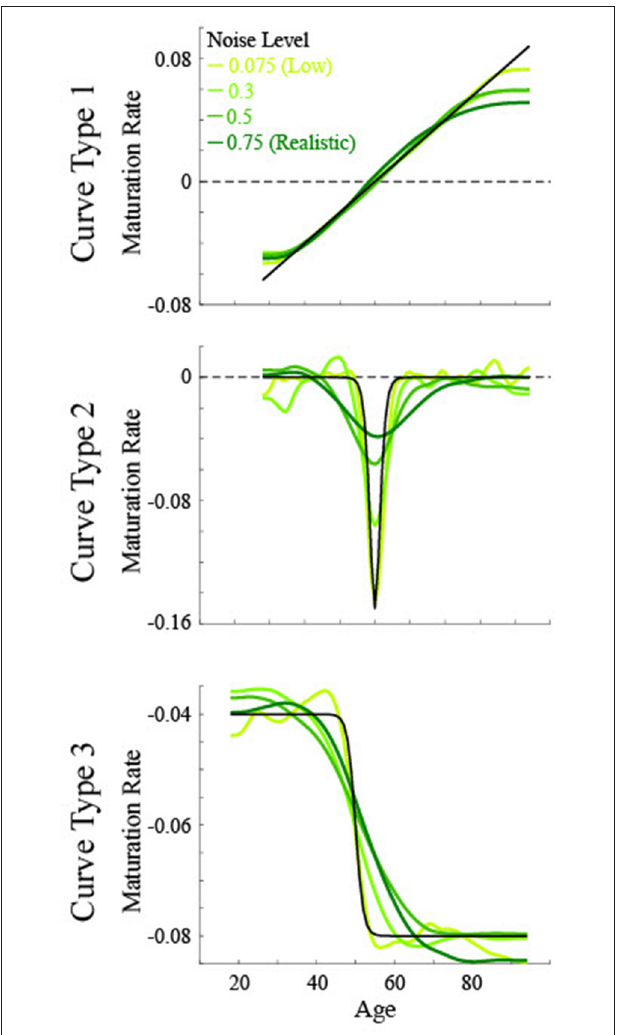
FIGURE 3 | Simulated maturation patterns for multiple noise levels based on three non-linear curve types. Solid black lines show the actual maturation pattern. Green lines show the 1st derivative of the smoothing spline fit to data of various noise levels. The critical age for all curves is 50.